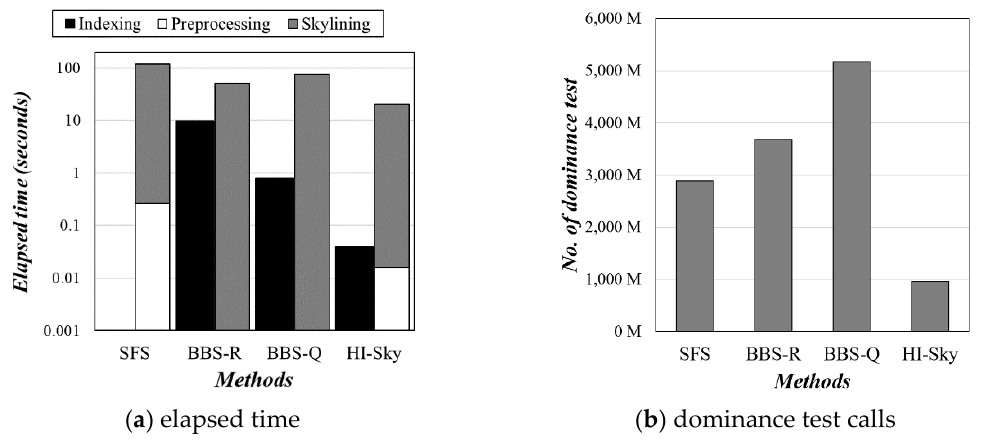
Figure 12. The experimental results using a real dataset.